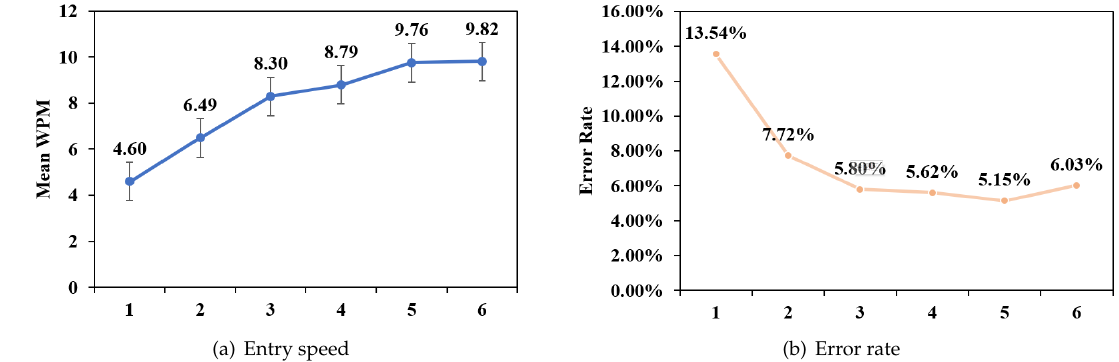
Figure 16. Mean entry speed ( a ) and error rate ( b ) across the 6